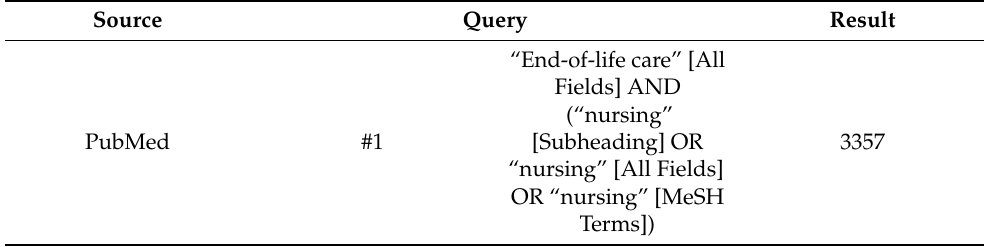
Table 1. Search criteria and